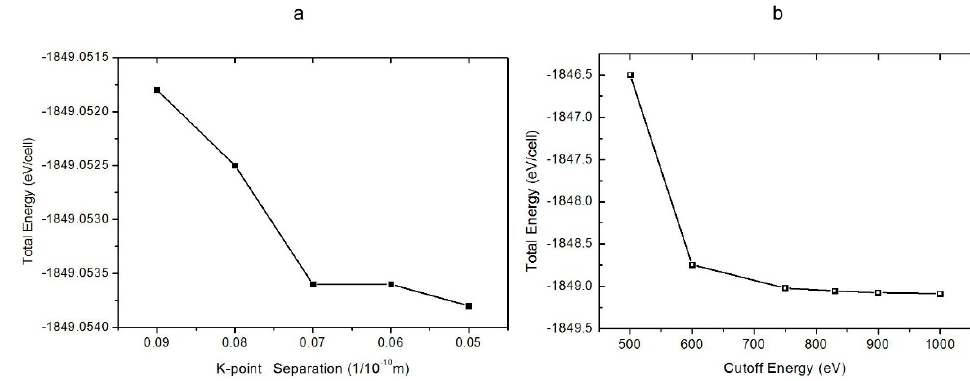
Figure 1. Diagram of the k-point and energy cutoff convergence tests. The total energy against k-point separation is shown in ( a ) and the cutoff convergence is shown in ( b ). The parameters used in this study were 0.07/Å for the k-point mesh and 830 eV for the energy cutoff.